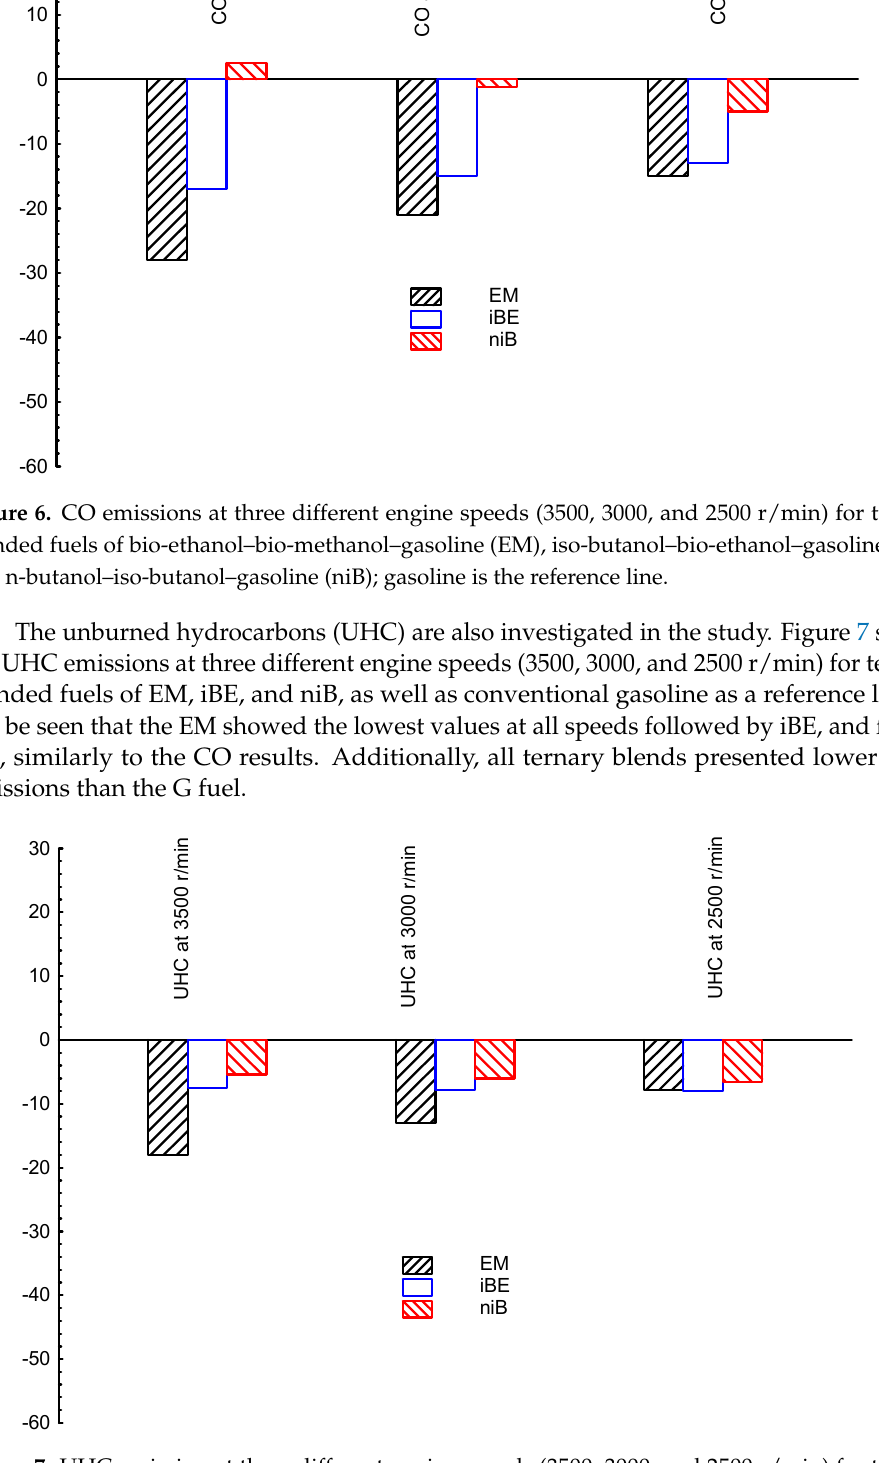
higher than the G fuel; while both iBE and niB showed lower CO 2 levels than the G fuel. The lowest CO 2 is introduced by niB among all ternary blends at all engine speeds, as shown in Figure 8. The CO 2 emissions for di ff erent blends are reproduced as averages for an easier comparison point of view, as presented subsequently. Figure 8. CO 2 emission at three di ff erent engine speeds (3500, 3000, and 2500 r/min) for ternary blended fuels of bio-ethanol–bio-methanol–gasoline (EM), iso-butanol–bio-ethanol–gasoline (iBE), and n-butanol–iso-butanol–gasoline (niB); gasoline is the reference line.